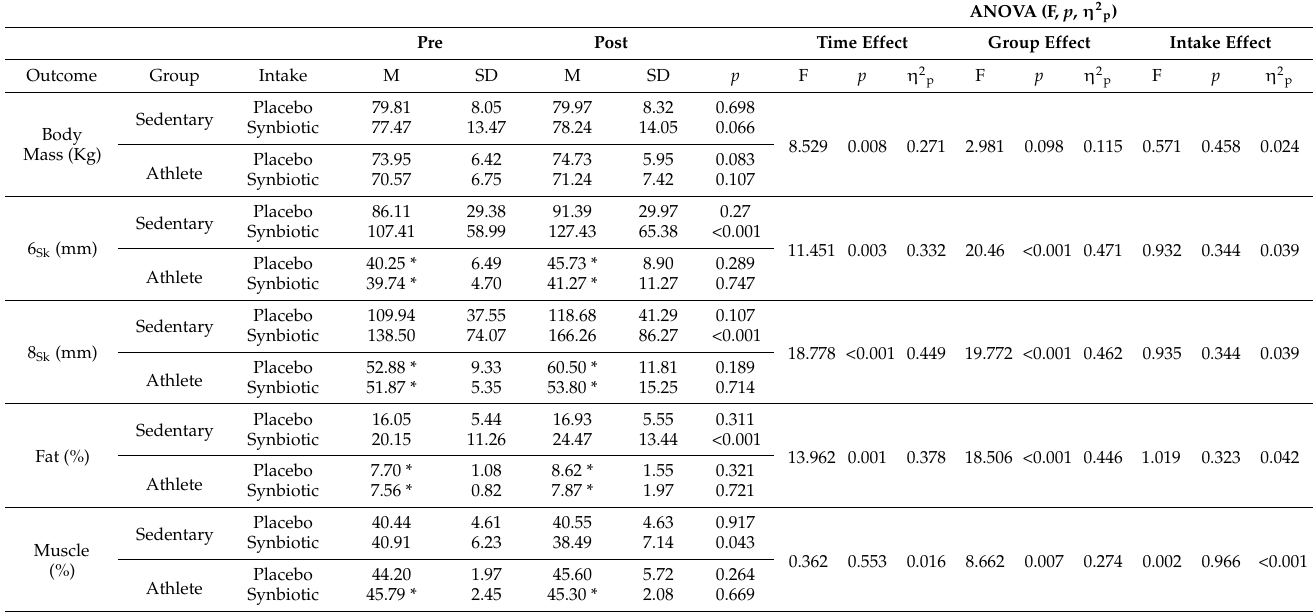
6 Sk : Sum of 6 upper-body skinfolds. 8 Sk : Sum of 8 skinfolds. * p < 0.05 compared to